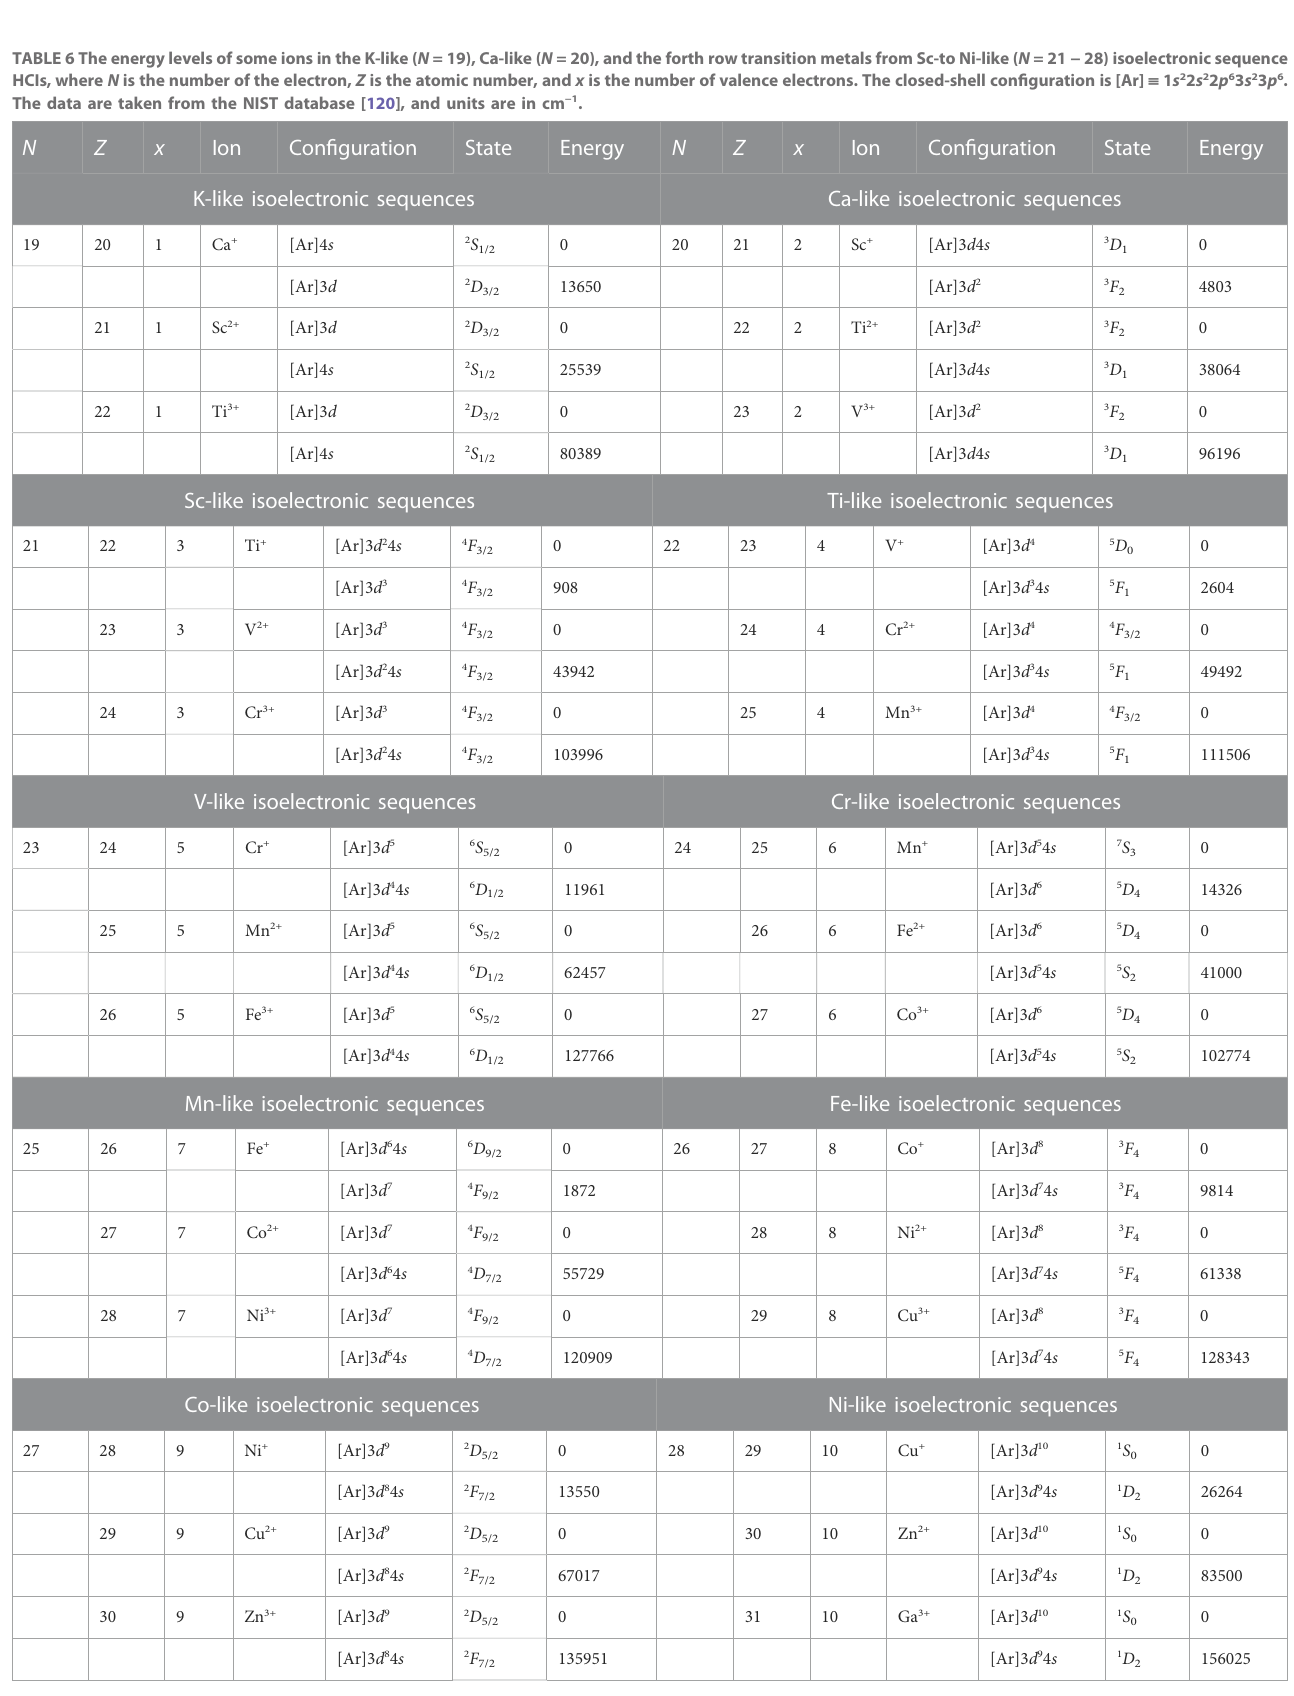
TABLE6TheenergylevelsofsomeionsintheK-like( N =19),Ca-like ( N =20),andthe forthrowtransitionmetalsfrom Sc-toNi-like( N =21 − 28)isoelectronicsequence HCIs, where N is the number of the electron, Z is the atomic number, and x is the number of valence electrons. The closed-shell con fi guration is [Ar] ” 1 s 2 2 s 2 2 p 6 3 s 2 3 p 6 . The data are taken from the NIST database [120], and units are in cm − 1 .